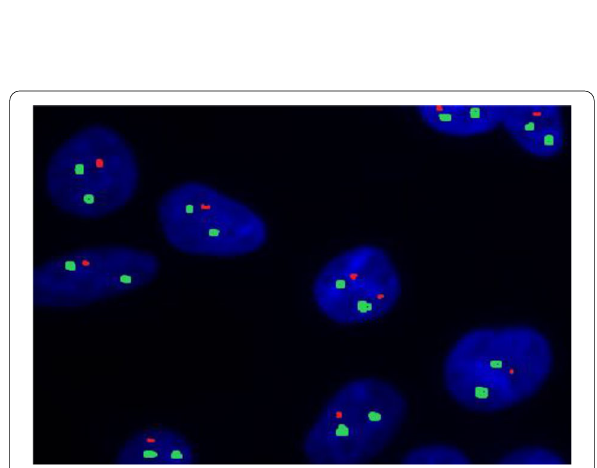
Fig. 2 Interphase FISH analysis using Vysis LSI TP53/CEP 17 FISH Probe showing positive result for heterozygous deletion of TP53(17p13). TP53(17p13) in red and CEP 17 in green